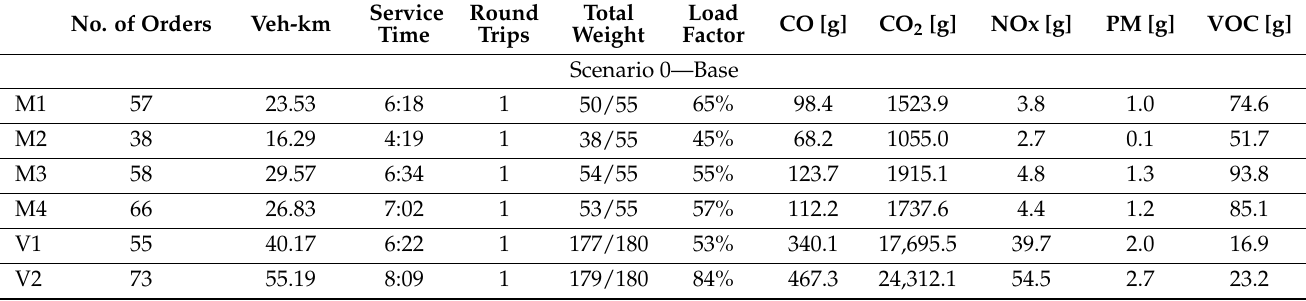
Table A1. Operator analysis results for all crowdshipping scenarios in absolute